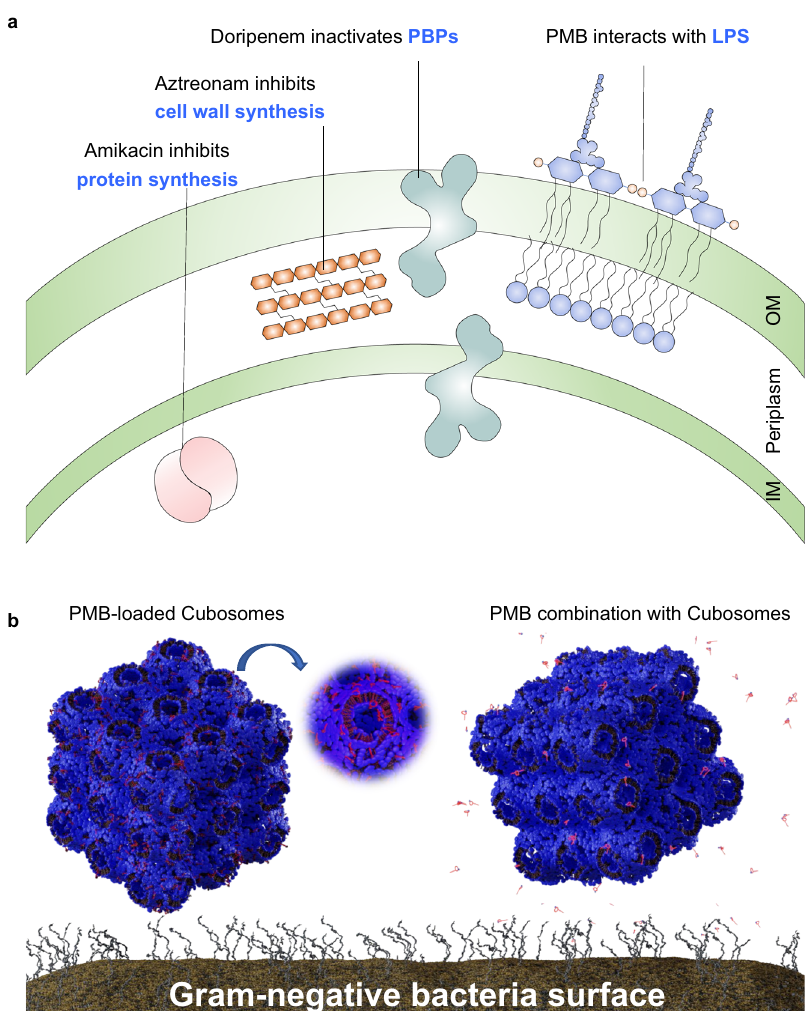
Fig. 1 The interaction of antibiotics and cubosomes with Gram-negative bacteria. a Schematic representation of the OM bilayer exposed to different antibiotics which are commonly used in the treatment of Gram-negative bacteria. Amikacin irreversibly binds to the 30S subunit of bacterial ribosomes, interfering with mRNA binding and tRNA acceptor sites, thereby blocking protein synthesis and inhibiting bacterial growth; Aztreonam inhibits the synthesis of the bacterial cell wall by blocking peptidoglycan crosslinking. Doripenem inactivates PBPs by forming stable acyl-enzymes, resulting in a weakened cell wall; PMB interacts with lipopolysaccharide (LPS) of the OM of Gram-negative bacteria, causing the leakage of cytoplasmic content and fi nally cell death. b Schematic diagram of PMB-loaded cubosomes and the polytherapy treatment interacting with the Gram-negative bacterial OM. OM outer membrane, IM inner membrane, PBPs penicillin-binding proteins, mRNA messenger ribonucleic acid, tRNA transfer ribonucleic acid, PMB polymyxin